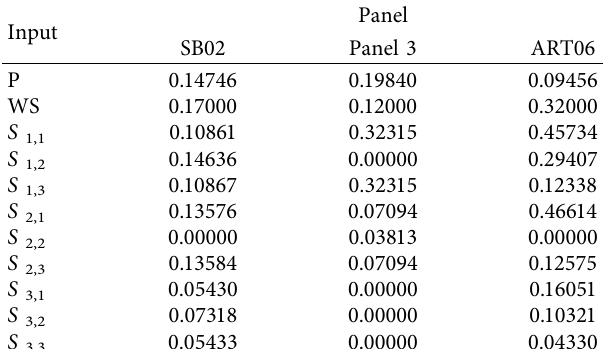
Table 3: Example of the input data for panels with an